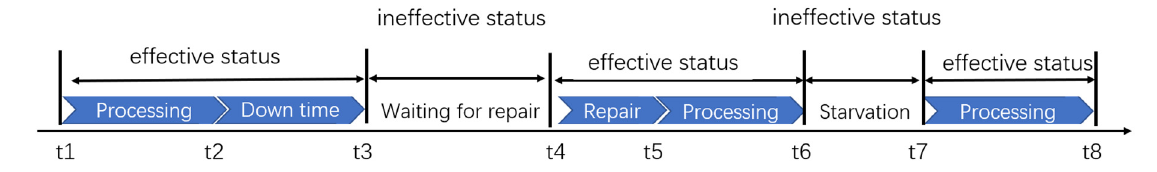
Figure 6. Effective states and ineffective states of the machine.